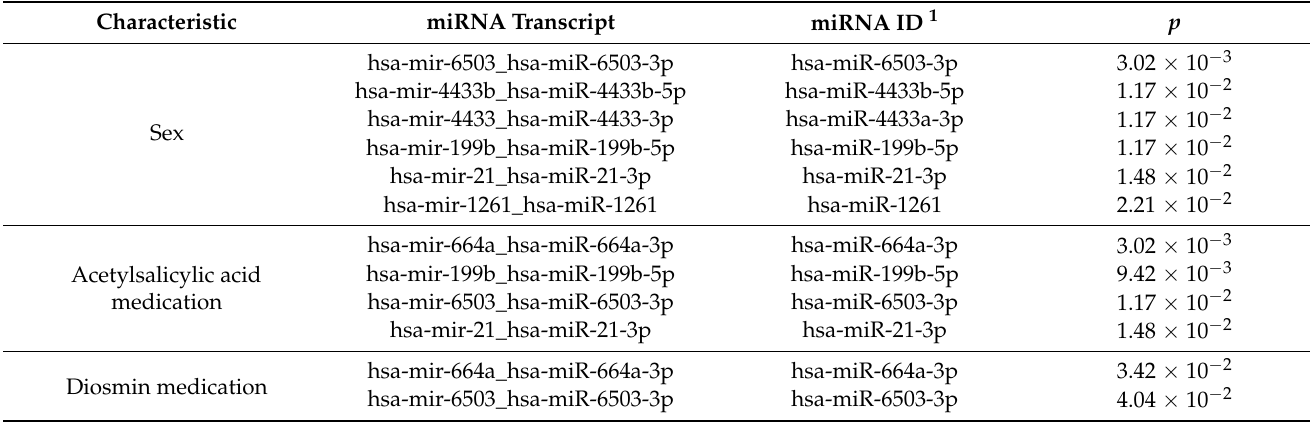
Table 3. Relationships between categorical characteristics of study subjects and expression of miRNA transcripts selected from LEAD vs. AAA, LEAD vs. CVD, and AAA vs. CVD comparisons. The table presents statistically significant relationships ( p < 0.05, Benjamini–Hochberg FDR correction) obtained from two-sided Mann–Whitney U test (the entire results are provided in Table S8).